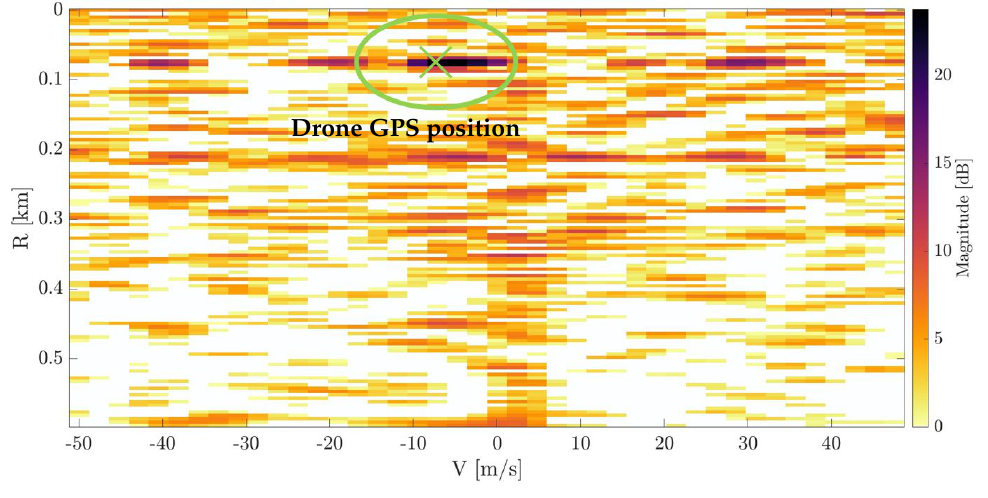
Figure 21. CAF with drone detection ( T int = 20 ms) with reference to its GPS position (green cross).